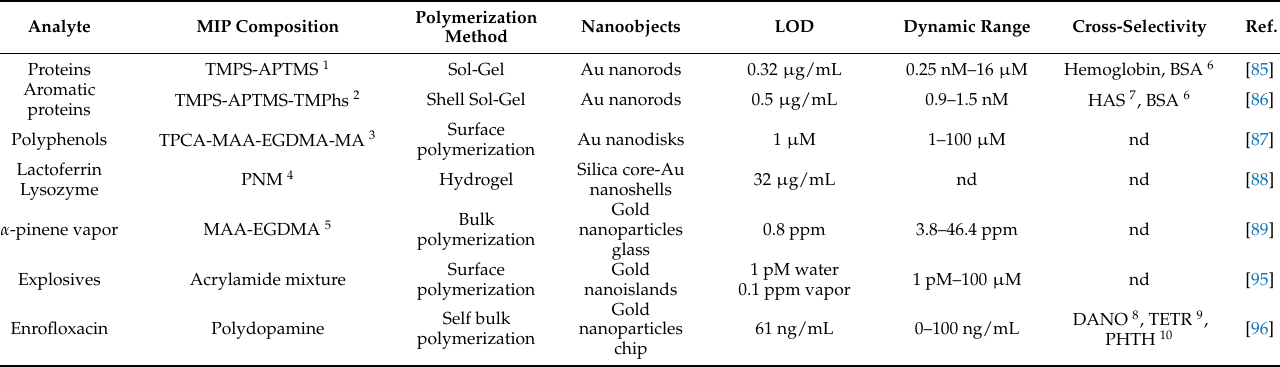
Table 3. Summary of the MIP-coated nanoparticles-based LSPR sensors described in Section